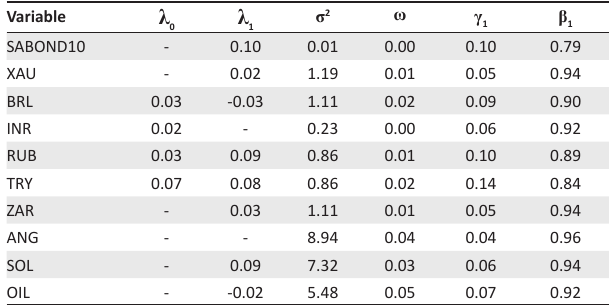
TABLE 3: Summary of the estimated coefficients of the ARIMA ( p ( p , q )